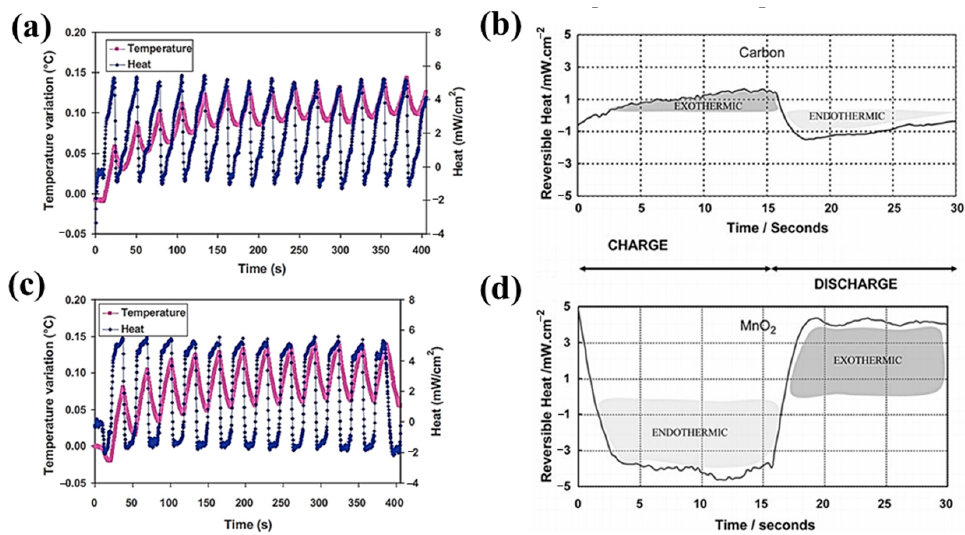
Figure 5. ( a ) Surface temperature vs. time during charging and discharging process for AC//AC and ( c ) AC//MnO 2 cell, ( b ) reversible heat curves vs. time with respect to the AC electrode, and ( d ) the MnO 2 electrode, reproduced with permission from [93]. Copyright 2011, Elsevier.